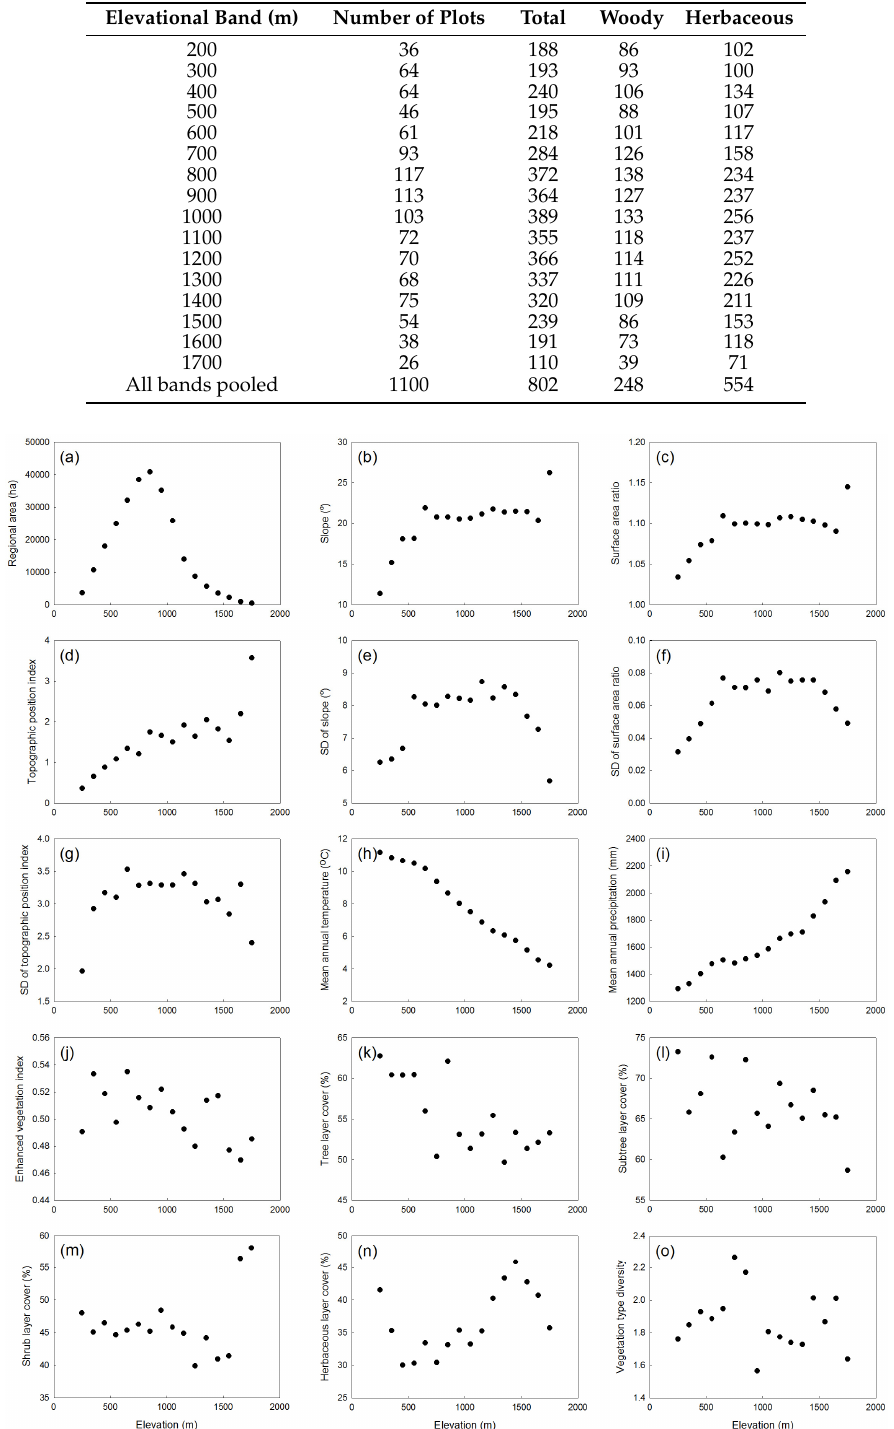
Figure 2. Relationships between elevation and ( a ) regional area; ( b ) slope; ( c ) surface area ratio; ( d ) topographic position index; ( e ) standard deviation (SD) of slope; ( f ) SD of surface area ratio; ( g ) SD of topographic position index; ( h ) mean annual temperature; ( i ) mean annual precipitation; ( j ) enhanced vegetation index; ( k ) tree layer cover; ( l ) subtree layer cover; ( m ) shrub layer cover; ( n ) herbaceous layer cover and ( o ) vegetation type diversity.